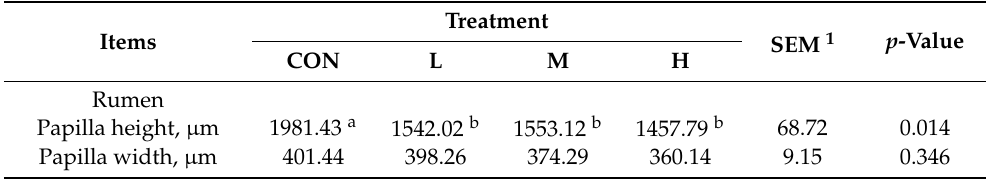
Table 5. Effects of replacing 0 (CON group), 20 (L group), 40 (M group) and 60% (H group) of maize silage with mulberry silage on lambs’ gastrointestinal tissue